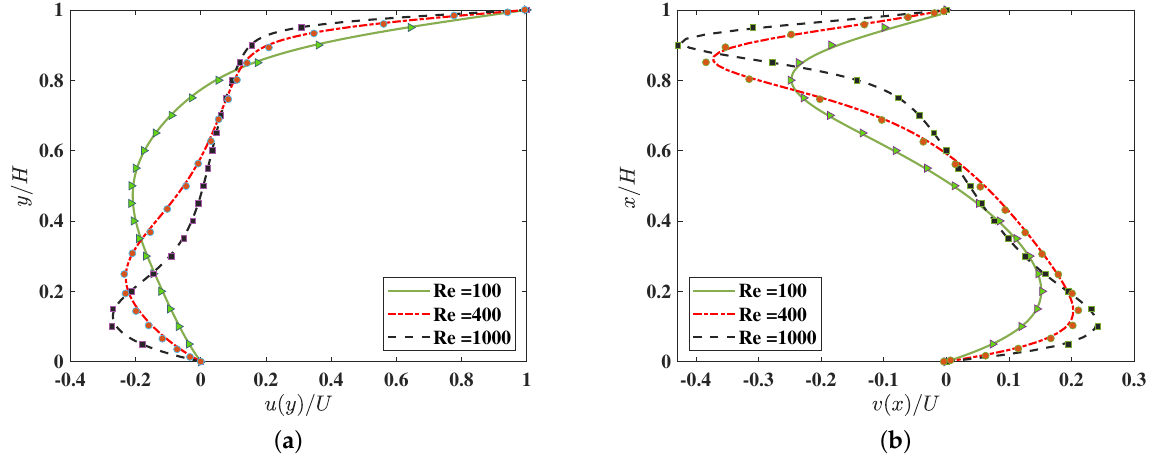
Figure 7. The velocity profiles along the centerlines of the 3D lid driven cavity flow for ( a ) u component along the y direction at x = 0.5 H and z = 0.5 H , and ( b ) v component along the x direction at y = 0.5 H and z = 0.5 H computed using the 3DCCM-LBM on a cuboid lattice with the grid aspect ratios of r = 0.5 and s = 1.0 at three different Reynolds numbers Re = 100, 400, and 1000 and compared with the reference numerical solution from Shu et al. [58]